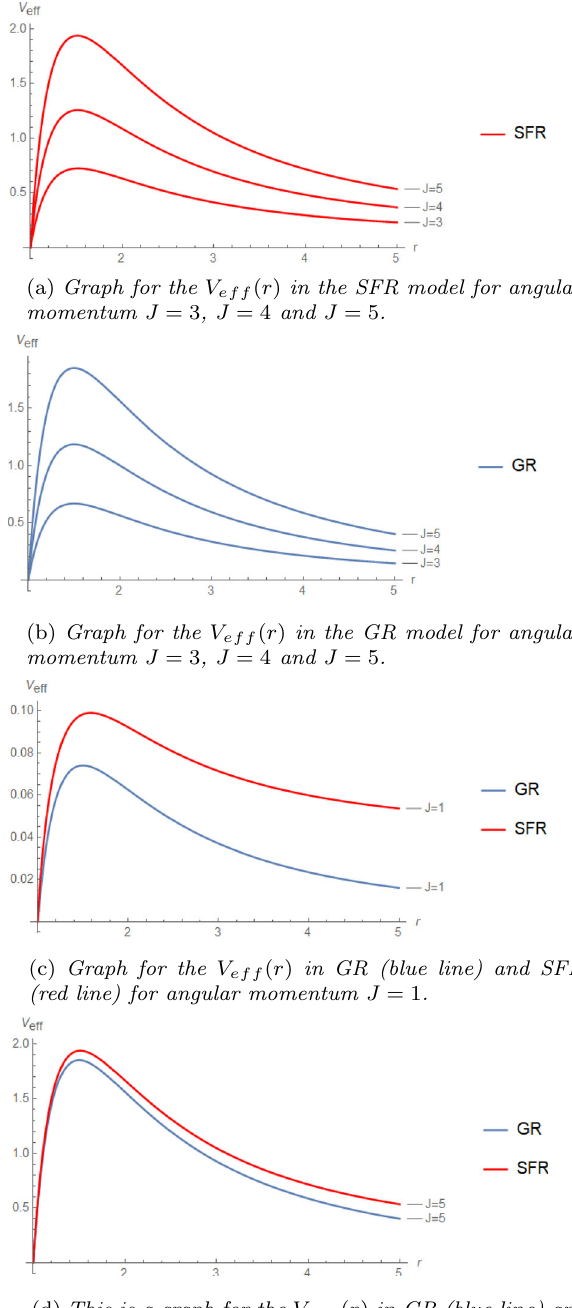
Fig. 3 These are the graphs for the V ef f ( r ) in the GR and SFR models for various angular